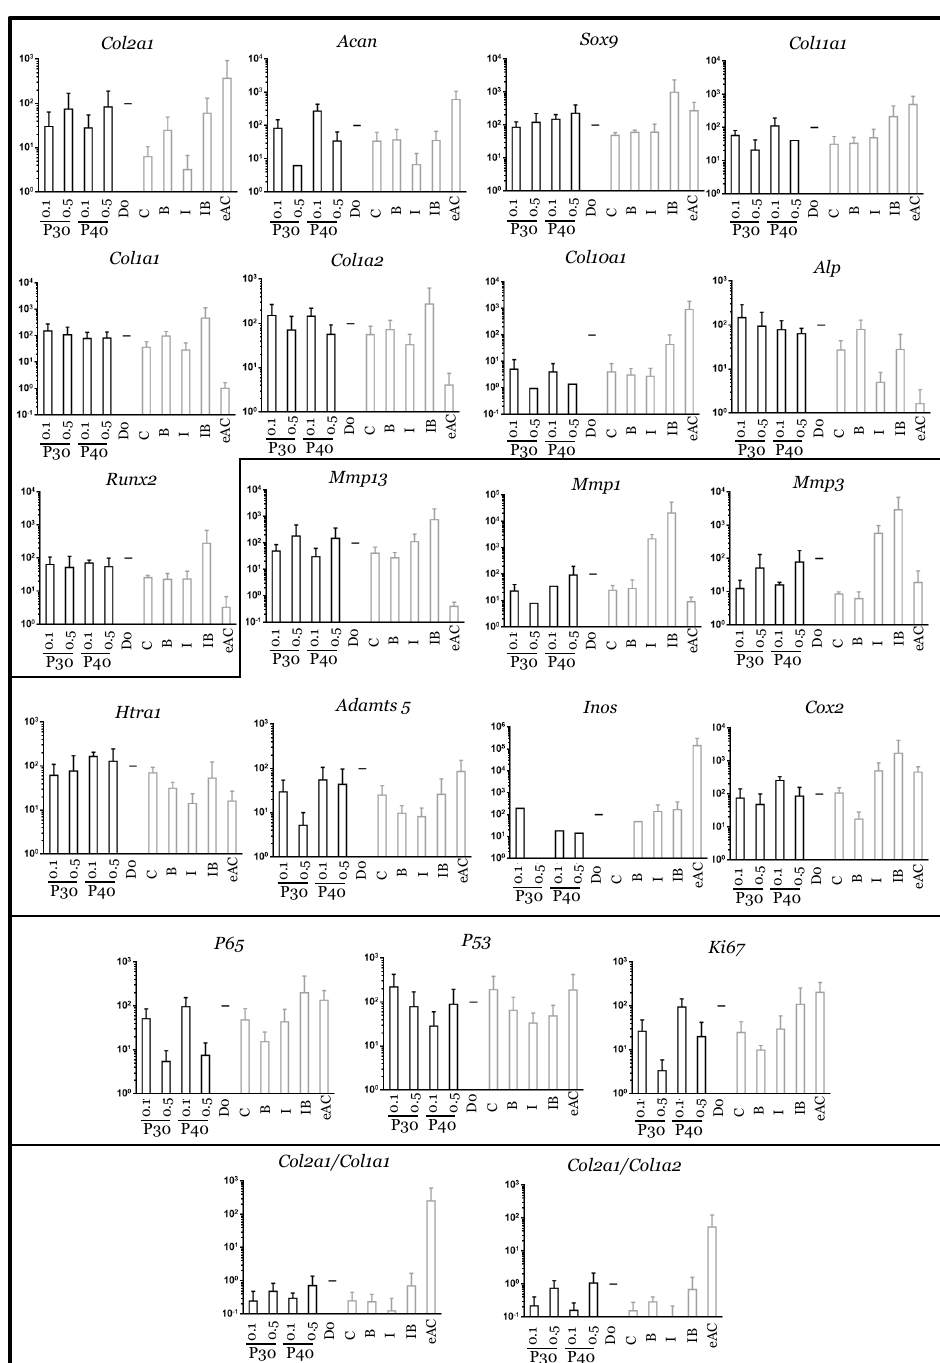
Figure 11. mRNA expression in equine articular chondrocytes treated with low concentrations of Promerim ® 30 and 40 in the presence of BMP-2. Equine articular chondrocytes were grown in type I/III collagen sponges at the third passage (P3). They were incubated during 7 days under hypoxia in the absence (C: control) or both the presence of BMP-2 + P30 and BMP-2 + P40, or BMP-2 alone (B), or IL-1 alone (I), or BMP-2 and IL-1 (IB). The Promerim ® were used at the concentrations of 0.1 and 0.5 µg/mL. The mRNAs were estimated using RT-qPCR after normalization with respect to the β -actin reference gene. Transcript expression is shown in arbitrary units. The Col2a1 : Col1a1 and Col2a1 : Col1a2 ratios are given. The results are shown as histograms and the significance of the values between the different treatments and the control case (BMP-2) was tested using a Mann–Whitney test; n = 3. eAC: mRNA extracts obtained from equine articular chondrocytes released from cartilage after overnight enzymatic digestion were used as controls. D0: cells seeded in sponges and arrested after 16 h of incubation. P30 and P40: Promerim ® 30 and